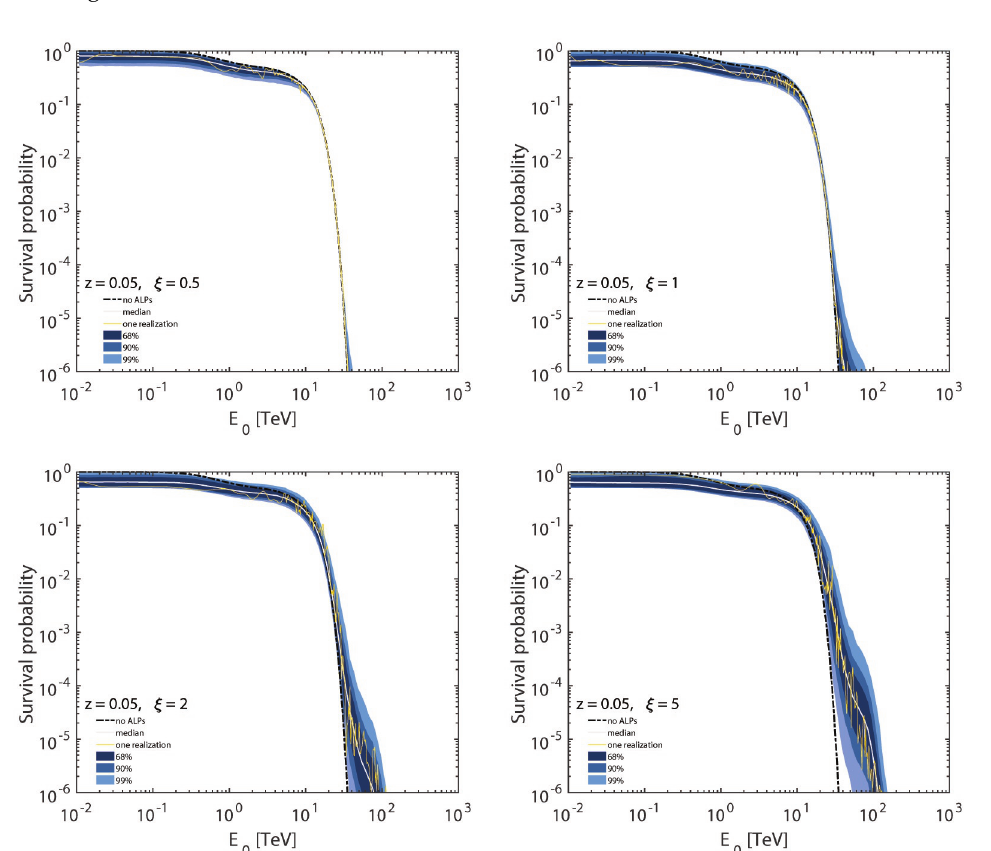
Figure 18. Same as Figure 17 apart from z = 0.05. (Credit [115]). Figures for z = 0.1.